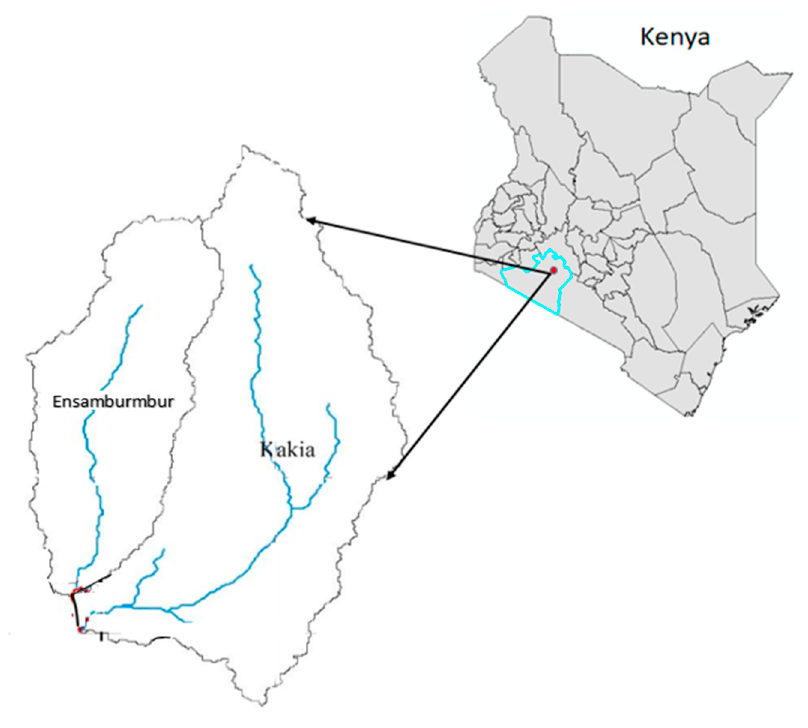
Figure 1. Kakia and Esamburmbur sub-catchments. The temperature ranges from a minimum of 8 ◦ C to a maximum of 28 ◦ C. Narok town watershed is formed by Kakia and Esamburmbur. The town has a population of around 40,000 people, mostly